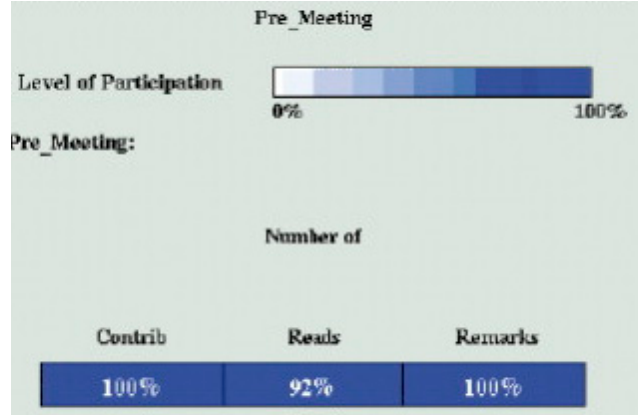
Figure 16. Participameter